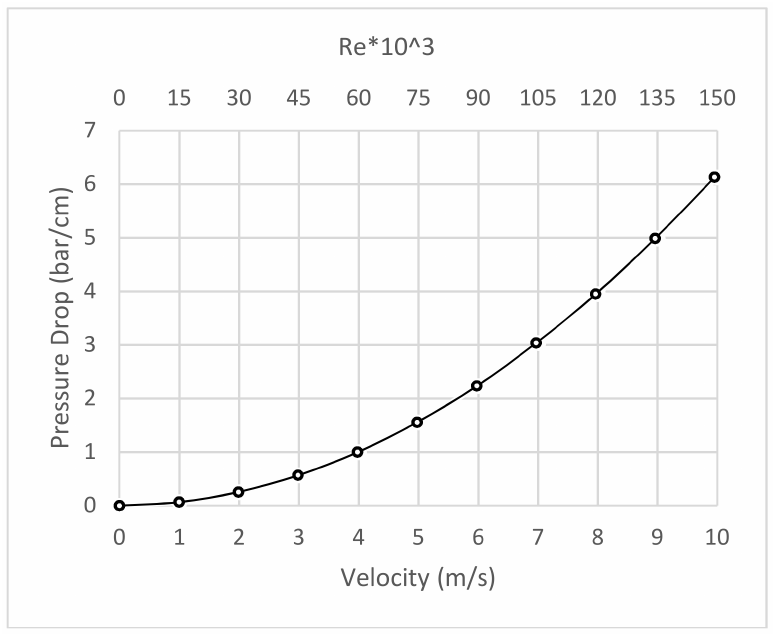
Figure 14. Pressure drop as a function of velocity for water at 20 ◦ C and 160 bar in 15 mm random